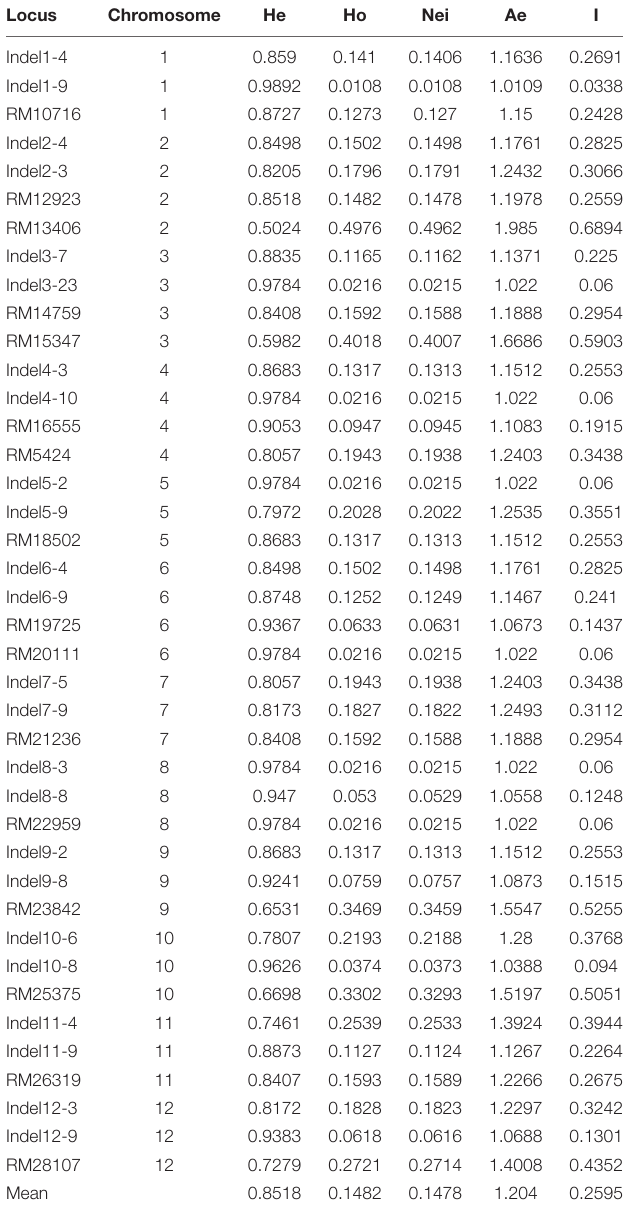
TABLE 1 | Genetic diversity-related parameters for different SSR and InDel loci. Locus